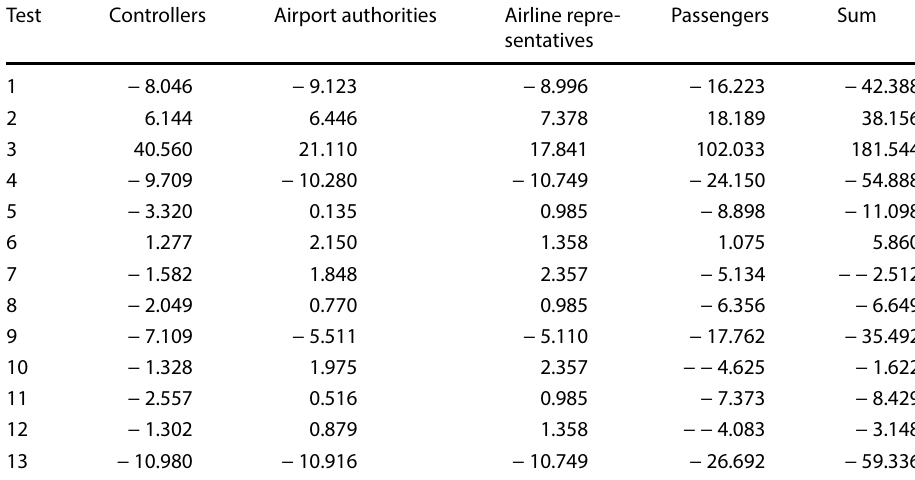
Fig. 4 The running time of FCFS and SA